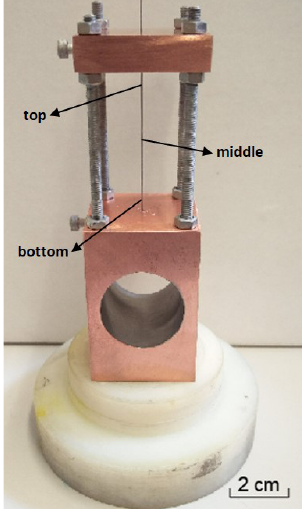
Figure 1. The new substrate holder dedicated to the coating of wires. Using the multilayer coated W wires, ignition tests were performed by applying a pulse of energy (electric source). The ignition was carried out as follows: (i) by a local electrical discharge (9 V)-mode I; and (ii) by passing a pulse of current (9 V) through the W wire-mode II (Figure 2).